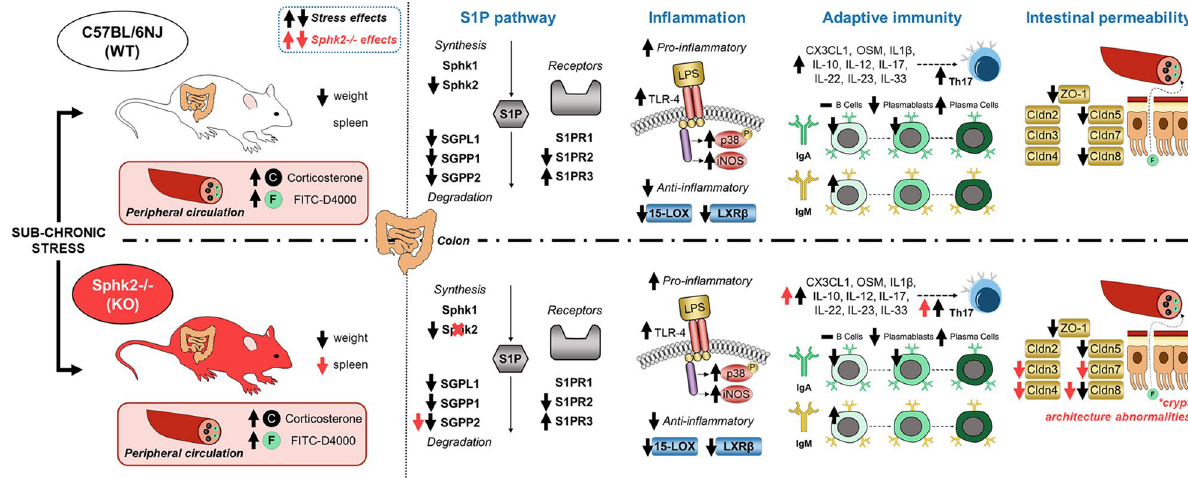
Figure 7. Graphical abstract. The upper part of the image illustrates the sub-chronic stress effects on wild- type (WT) mice. The lower part describes the sub-chronic stress effects on Sphk2 knockout (Sphk2−/−) mice. The black arrows represent the stress effects, and the red arrows the Sphk2 deletion effects. The figure was prepared using the Motifolio Illustration Toolkits (https:// motif olio. com) (Motifolio Inc., Ellicott City, MD, USA) and edited with Microsoft PowerPoint 365 (Microsoft Corporation, Redmond, WA, USA). WT: wild- type; Sphk2−/−: Sphk2 knockout; FITC-D4000 (F): fluorescein isothiocyanate-dextran average MW 4,000; S1P: sphingosine-1-phosphate; Sphk1: sphingosine kinase 1; Sphk2: sphingosine kinase 2; SGPL1: sphingosine- 1-phosphate lyase 1; SGPP1: sphingosine-1-phosphate phosphatase 1; SGPP2 sphingosine-1-phosphate phosphatase 2; S1PR: sphingosine-1-phosphate receptor; TLR4: Toll-like receptor 4; p-p38: phospho mitogen- activated protein kinase (MAPK) p38; iNOS: inducible nitric oxide synthase; 15-LOX: 15-lipoxygenase; LXRβ: Liver X Receptor β; ZO-1: zonula occludens-1.; Cldn: claudin; CX3CL1: (C-X3-C motif) chemokine ligand 1 (fractalkine); OSM: oncostatin M; IL: interleukin; Th17: T-helper lymphocyte 17; Ig: